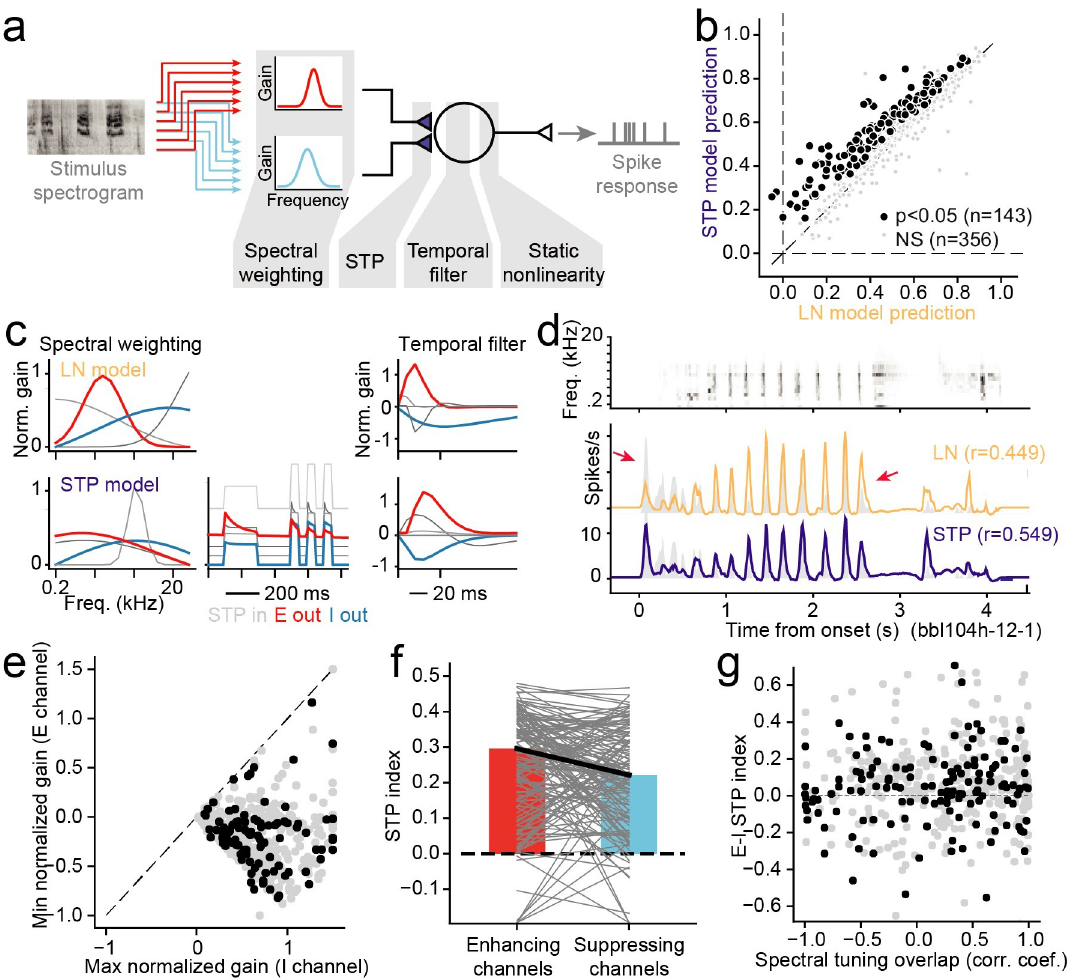
Fig 9. Performance of a local STP model on for A1 encoding of natural sounds. A. The encoding model for natural sounds resembled reweighted STP model for vocalization-modulated noise, except that the spectral filters at the first stage were two independently fit Gaussian functions that required two free parameters each (mean, standard deviation) and provided a simple tuning function for each spectral channel. B. Scatter plot compares prediction accuracy between the LN model and local STP model for the natural sound data. Across the entire set, 143/499 neurons showed a significant improvement in prediction accuracy for the local STP model ( p < 0.05, jackknife t -test).Mean prediction accuracy for the local STP model was significantly greater than the LN model (0.517 vs. 0.563, p < 10 − 10 , sign test). C. Example spectral weights and temporal filters for one LN model (top) and spectral weights, STP, and temporal filters for the local STP model for the same neuron. Maximum gain is normalized to 1, but the relative gain between channels is preserved. As is typical in the vocalization-modulated noise data, the highest gain filter (red) shows relatively strong STP, and the lowest gain (blue) shows weaker STP. D. Predicted PSTH responses for each model for one natural sound stimulus, overlaid on the actual PSTH (gray). The LN model prediction (orange) undershoots the initial transient response and over-predicts the sequence of transient responses later in the stimulus (arrows), while the STP model predicts these features more accurately (blue). E. Comparison of gain for the most positive (max normalized gain) and most negative (min normalized gain) linear filter channels for STP models reveals that the majority fits contain one excitatory and one inhibitory channel. F. Comparison of STP strength between excitatory and inhibitory channels shows consistently stronger depression for the excitatory channels (mean 0.30 vs. 0.22, p = 4.1 x 10 − 3 , sign test, n = 143 units with significant improvement for the STP model). G. Scatter plot compares overlap of E and I spectral channels for each STP model (x axis) and relative difference in STP index between the E and I channels. There is no correlation between tuning overlap and STP index difference, suggesting that A1 neurons represent incoming sound with a diverse combination of spectral tuning and nonlinear